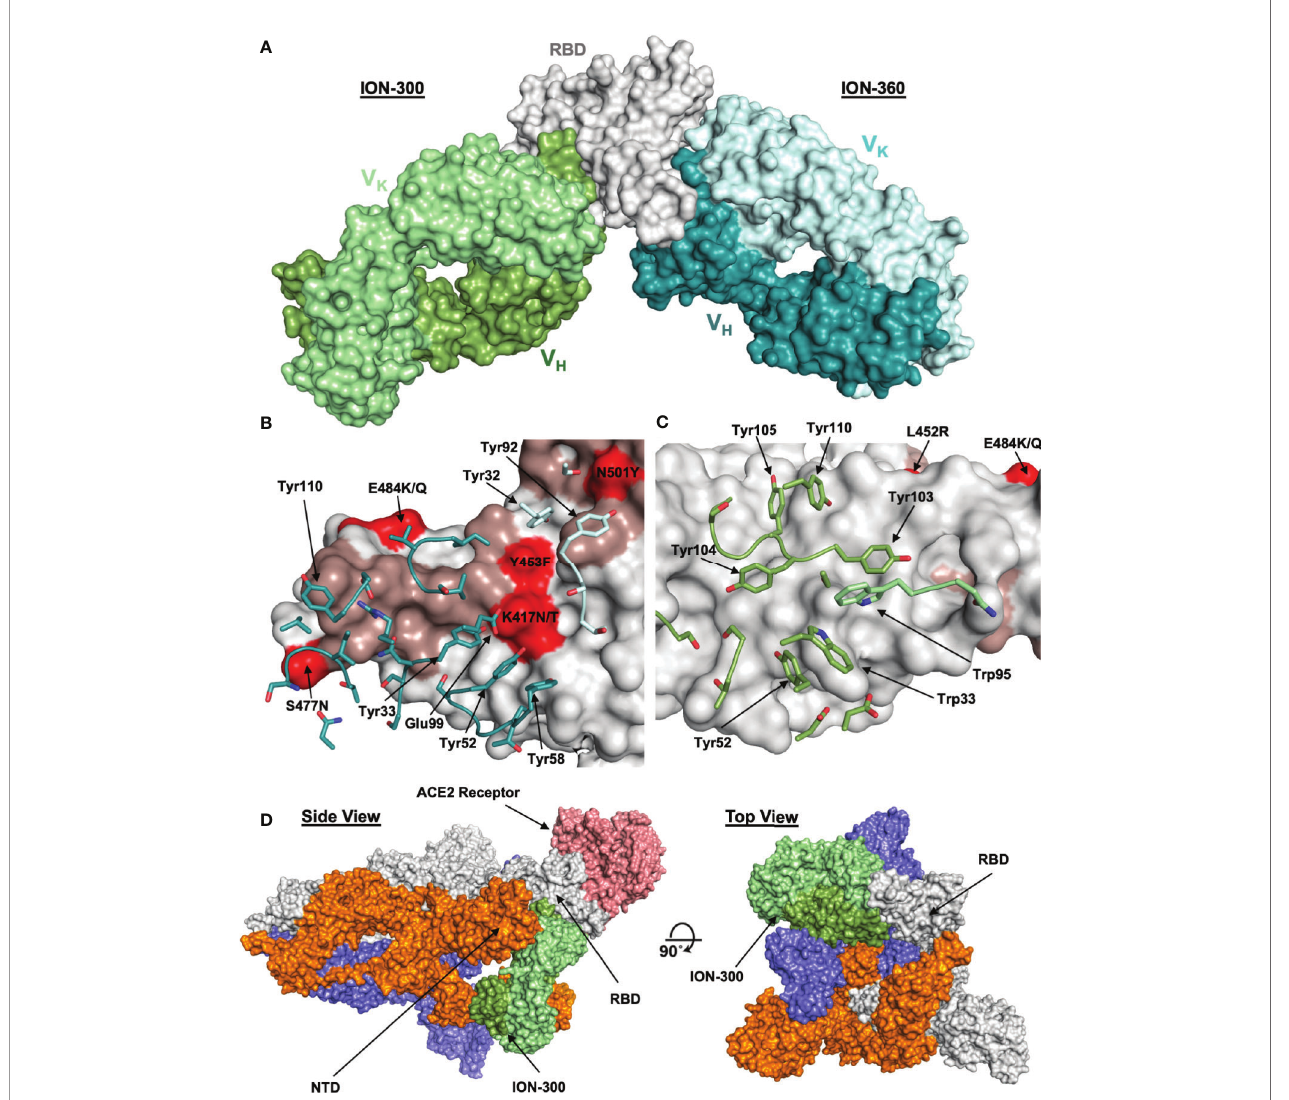
FIGURE 4 | Structures of ION_300 and ION_360 antibodies bound to SARS-CoV-2 RBD. (A) Molecular surface representation of ION_300 (greens) and ION_360 (blues) overlayed by their bound RBD (grey). (B) Analysis of the RBD : ION_360 interface. CDR residues within 5 Å of the RBD are shown in sticks for the VH (blue) and VK (pale blue) chains. (C) Analysis of RBD:ION_300. CDR residues within 5 Å of the RBD are shown in sticks for the VH (green) and VK (pale green) chains. In both B and C RBD is represented as a surface (grey) with ACE2 binding residues highlighted (salmon). RBD mutations found within the three major